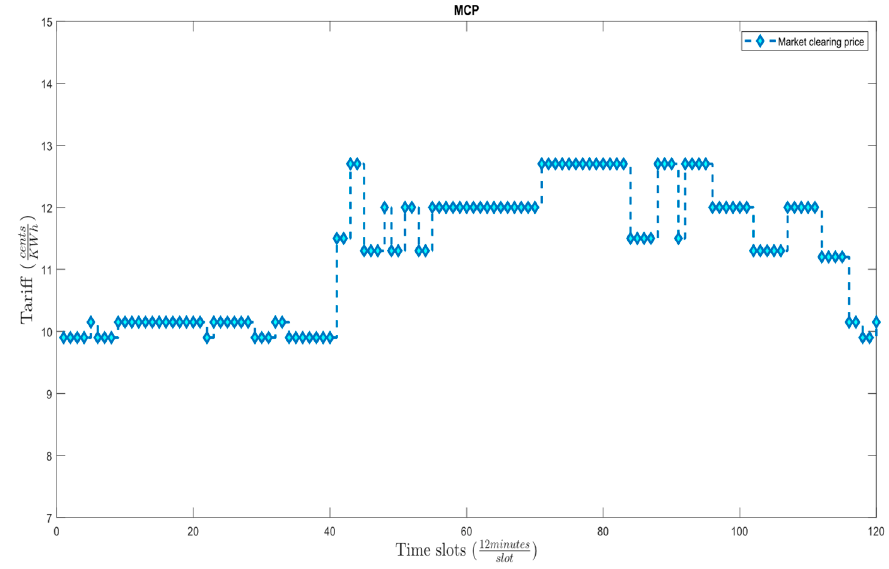
Figure 21. MCP determined for energy trading in LETM for scheduled load using MJLBO.